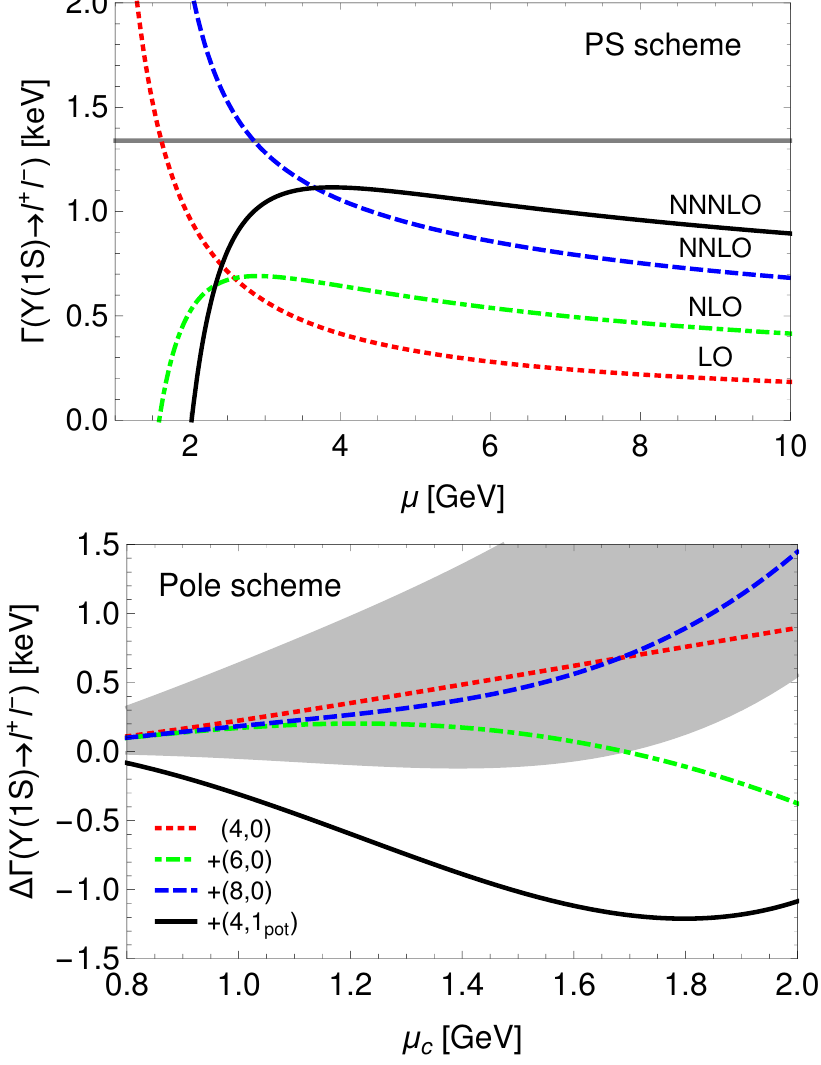
Figure 7 . The top panel shows the perturbative contribution to the leptonic decay width of the (cid:7)(1 S ) resonance. The curves in the bottom panel show the e(cid:11)ects of cumulatively adding the condensate contributions ( i; j ) where i denotes the dimension and j the order in perturbation theory. The gray band is spanned by variation of O 0 by factors of 0 and 3, while O 1 and O 2 are unchanged. In this (cid:12)gure the gray band does not contain the potential corrections to the dimension-four